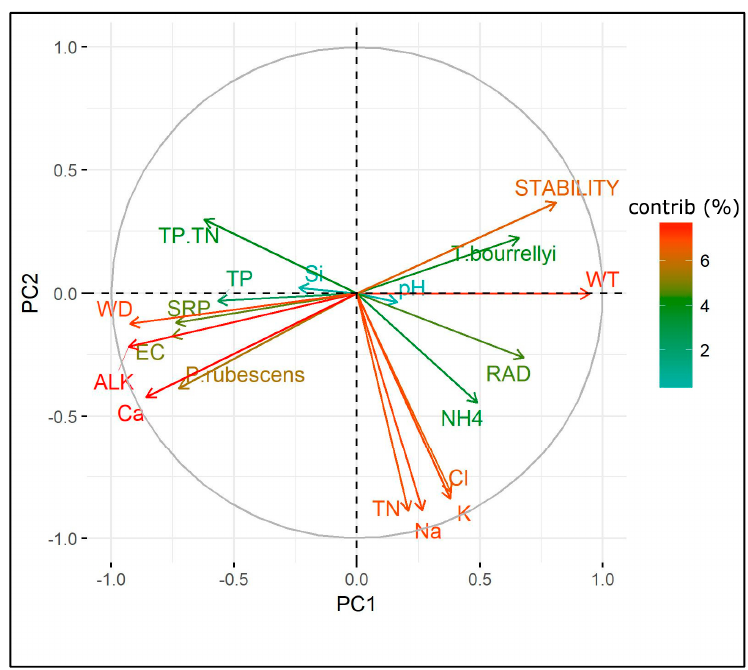
Figure 7. Loading plot of the first two components of the final principal component analysis (PCA) performed on biovolume values of P. rubescens and T. bourrellyi and 20 chemico-physical variables, detected at depths from 0 to 40 m during February, March, April, and May.